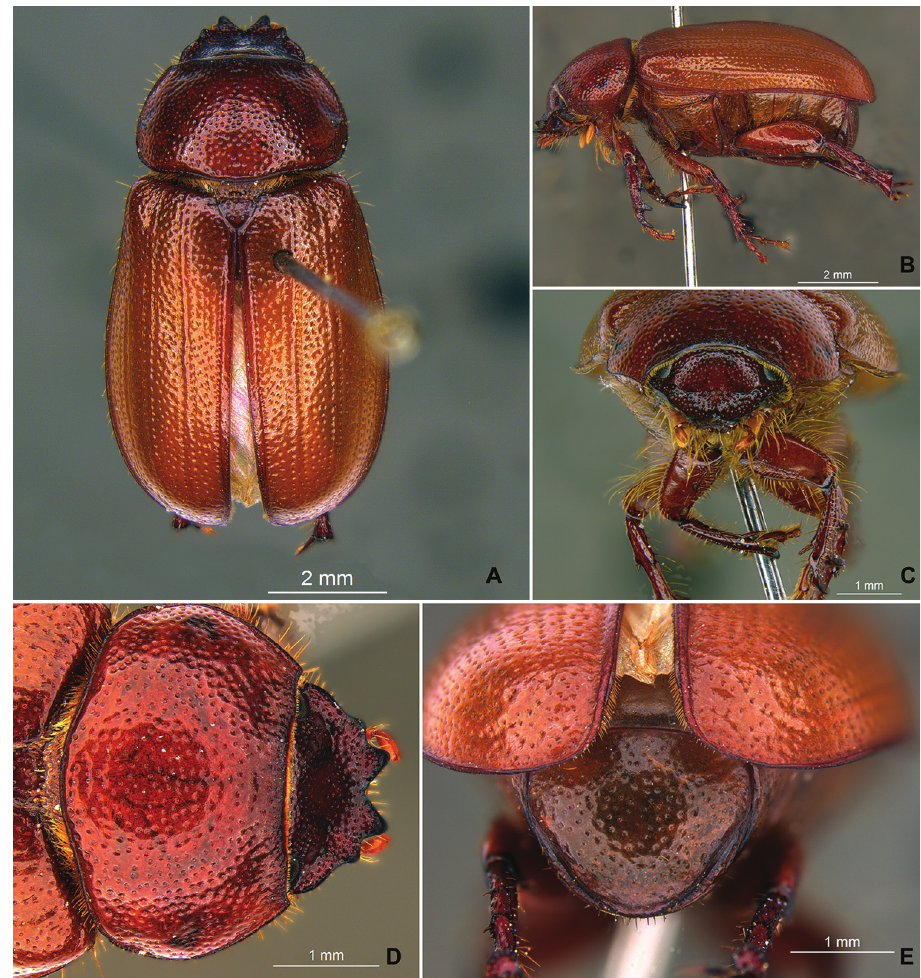
Figure 80. Liogenys femella Cherman, sp. n. A Dorsal view B Lateral view C Frontal view D Clypeus and pronotum E